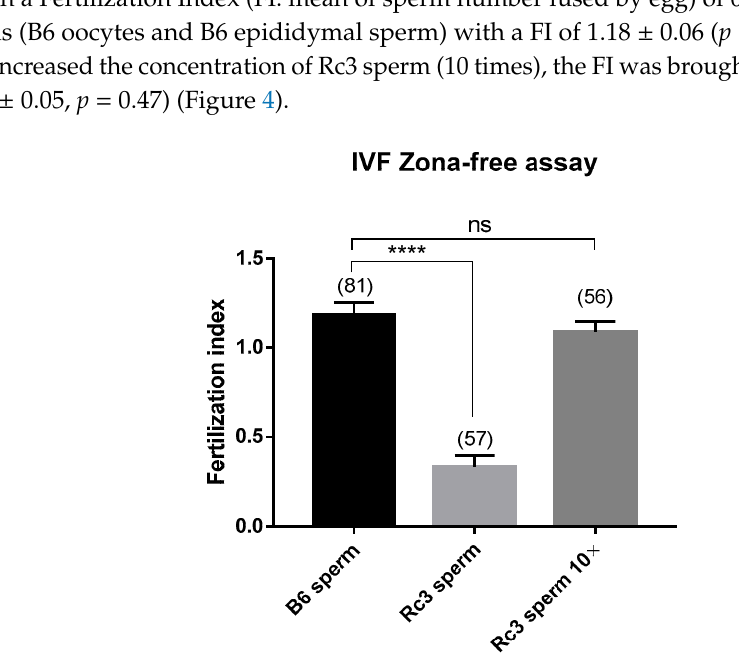
Figure 4. Evaluation of in vitro fertilization (IVF). The fertilization index (or mean ± SEM of sperm number fused by egg) was assessed by zona-free IVF assay at 10 5 (B6 and Rc3 sperm) or 10 6 (Rc3 sperm 10×) sperm per mL. Experiments were repeated at least three times. ( ): number of oocytes. ns: non significant. ****: p < 0.0001.